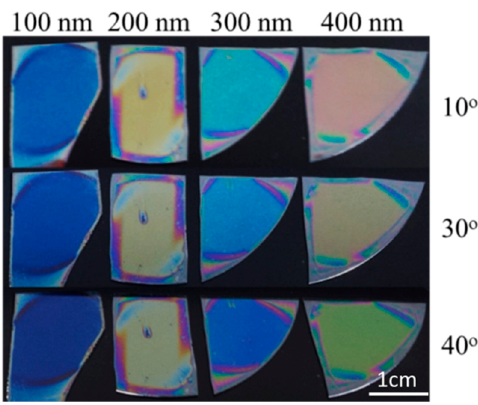
Figure 5. Pictures of polymer films with thicknesses of 100, 200, 300, and 400 nm deposited on silicon substrate at three viewing angles—10, 30, and 40 degrees.